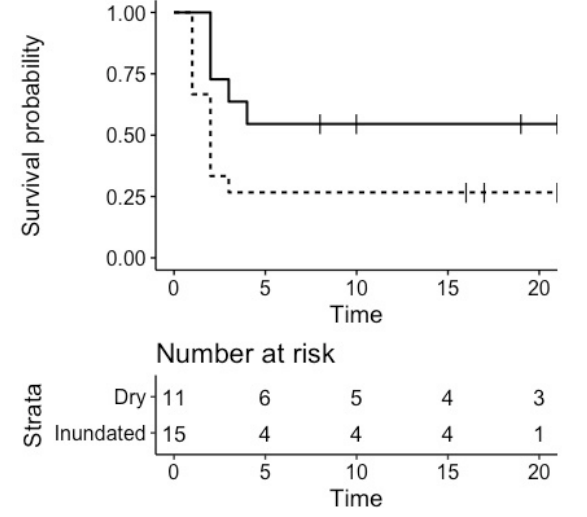
Fig. 2 . Kaplan Meier plot showing the postfledging survival of Yellow Warblers ( Setophaga petechia ) from territories within the drawdown zone of the Upper Arrow Lakes Reservoir in British Columbia, Canada that were inundated (dashed line) or not inundated (solid line) by water at the time of fledging. Censored data are indicated with a |.